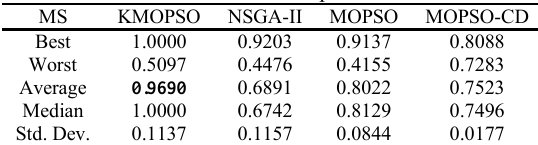
Table 19 . Results of the maximum spread metric for ZDT4.